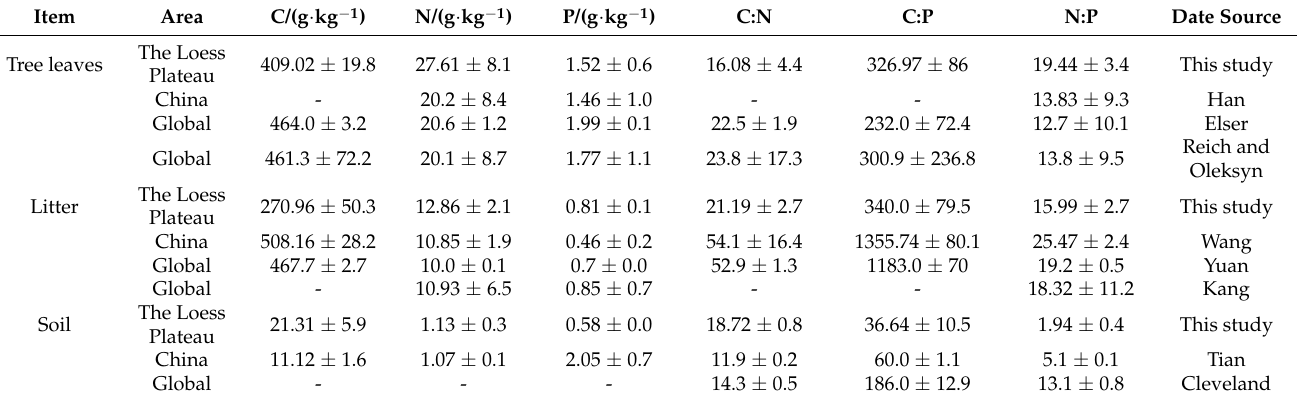
Table 4. Statistics of the “plant-litter-soil” C, N, and P contents and ratios in this study and previous studies. Item